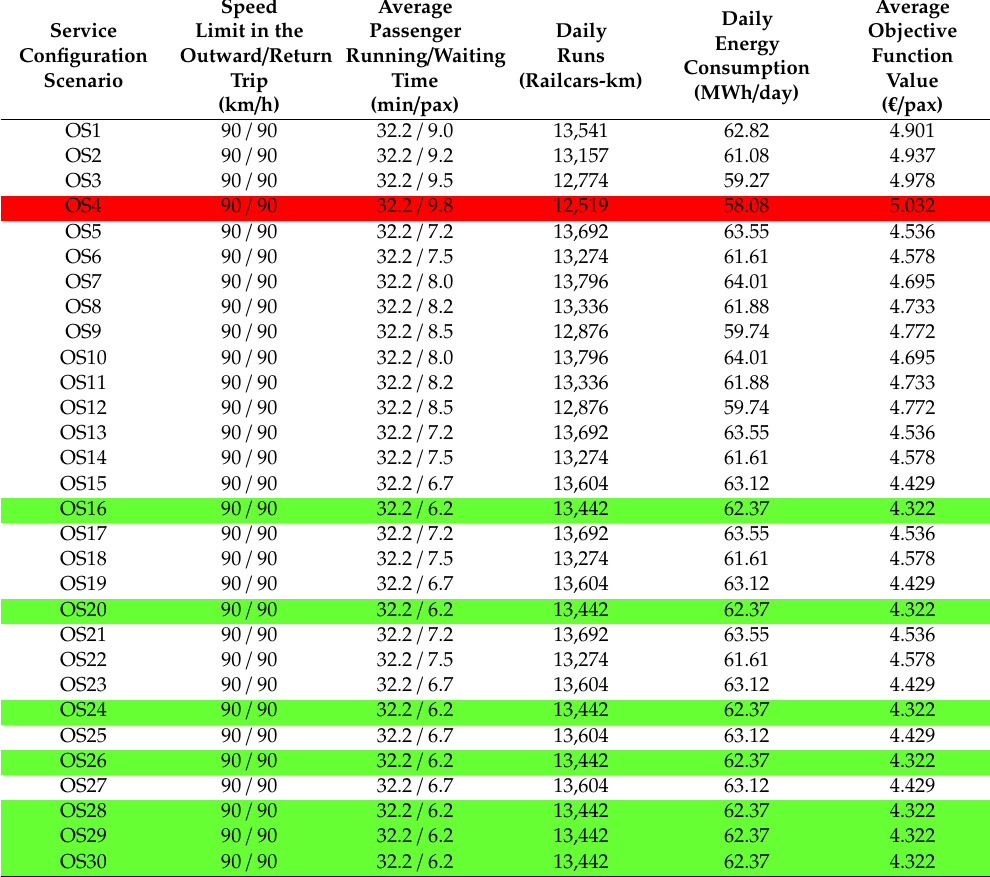
Table 4. Operational parameters in the case of the time-optimal strategy (ordinary